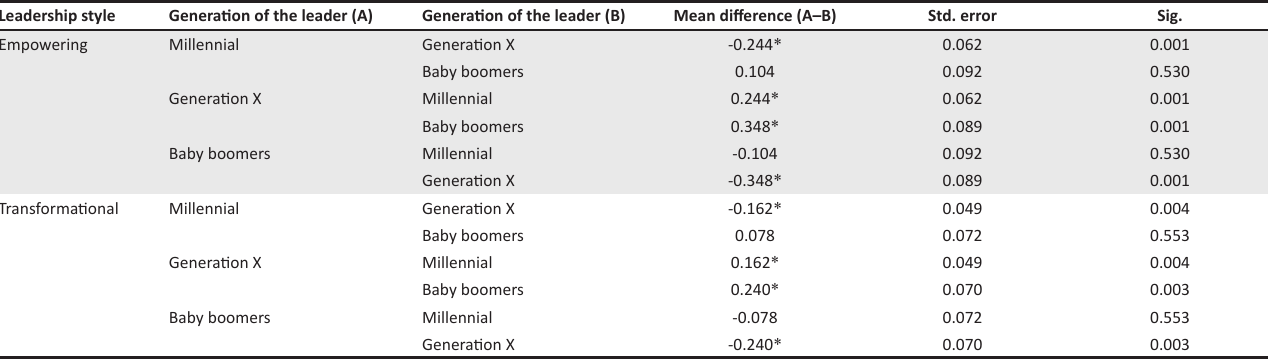
TABLE 7: Scheffé post hoc test. Leadership style Generation of the leader (A) Generation of the leader